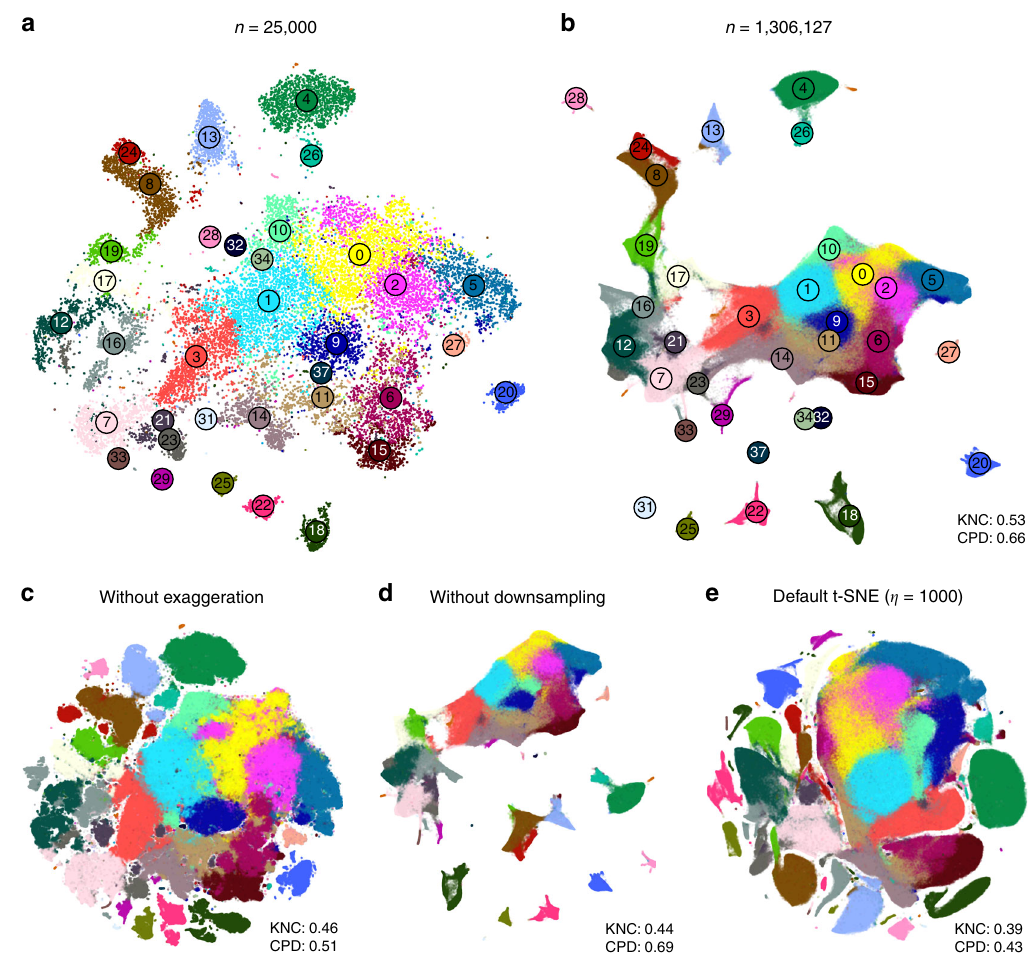
Fig. 7 10x Genomics data set. Sample size n ¼ 1 ; 306 ; 127. Cluster assignments and cluster colours are taken from ref. 23 . a T-SNE of a random subsample of 25 ; 000 cells (PCA initialisation, perplexity combination of 30 and 250, learning rate 25 ; 000 = 12). Cluster labels for several small clusters (30, 35, 36, and 38) are not shown here and in b because these clusters were very dispersed in the embeddings. b T-SNE of the full data set. All cells were positioned on the embedding in panel a and this was used as initialisation. Perplexity 30, exaggeration 4, learning rate n = 12. c The same as in b but without exaggeration. d The same as in b but with PCA initialisation, i.e. without using the downsampling step. e Default t-SNE with learning rate set to η ¼ 1000: random initialisation, no